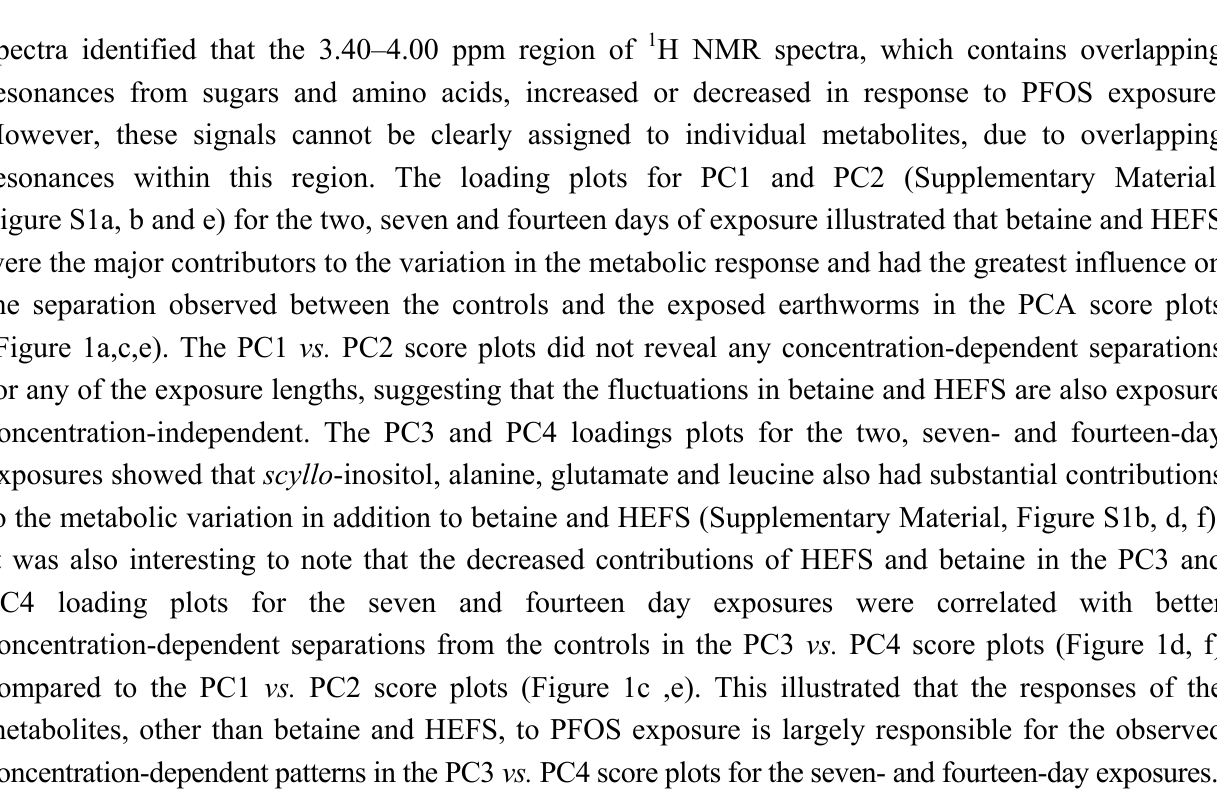
Figure 1. Average principal component analysis (PCA) score plot for the 1 H NMR spectra of Eisenia fetida tissue extracts after perfluorooctane sulfonate (PFOS) exposure of two days, ( a ) PC1 (first PCA component) versus PC2 (second PCA component), ( b ) PC3 (third PCA component) versus PC4 (fourth PCA component), seven days, ( c ) PC1 vs. PC2, ( d ) PC3 vs. PC4, and fourteen days, ( e ) PC1 vs. PC2, ( f ) PC3 vs. PC4. The mean scores for